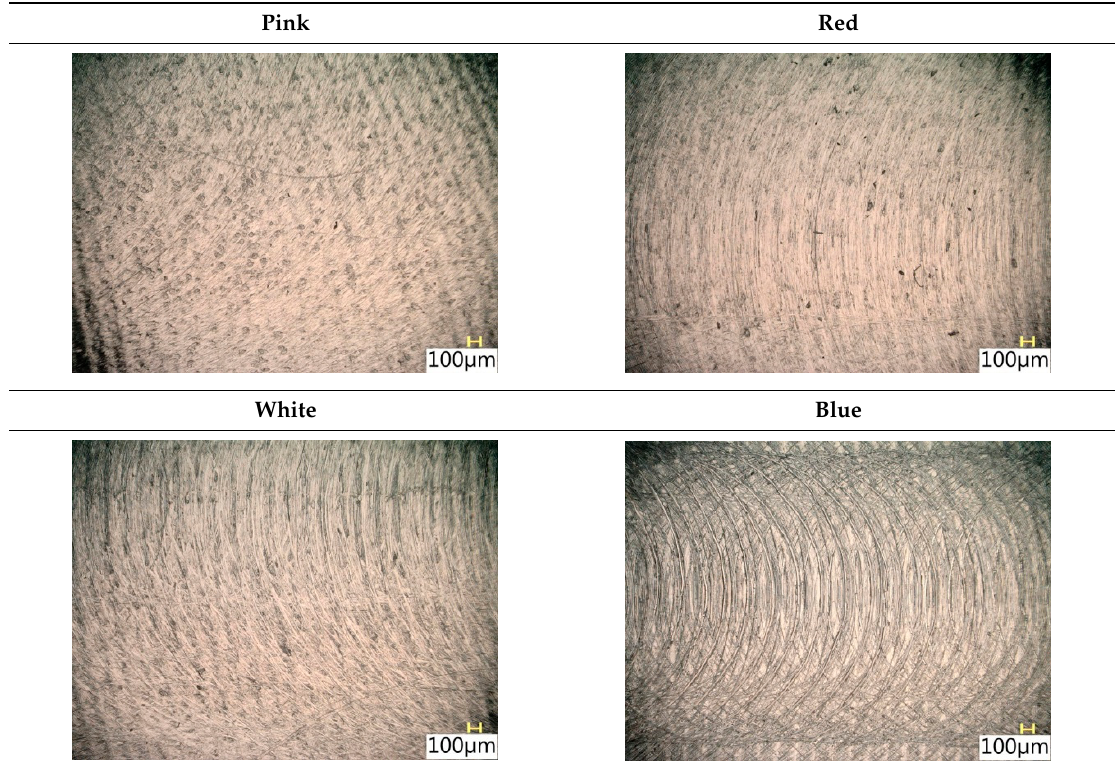
Table 5. Surface texture after brushing with the “low” spring in the offset adjustment sleeve. Pink Pink Pink Red